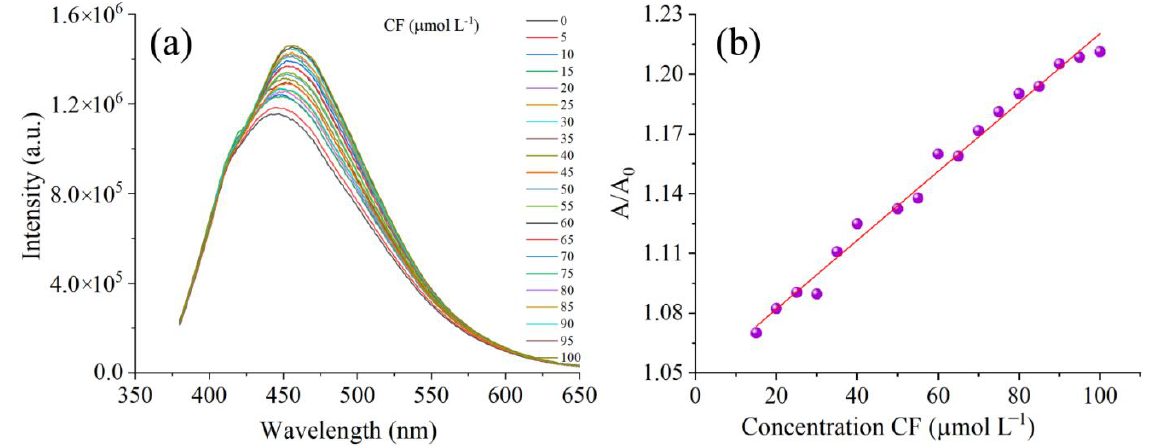
Figure 11. Emission spectra of the GQDs-EDA/1 g recorded at λ exc = 360 nm in the presence of CF in the concentration range 0 – 100 µmol L −1 ( a ), and plot which presents an integrated area under emission peak versus concentration of CF with a linear fitting curve ( b ).